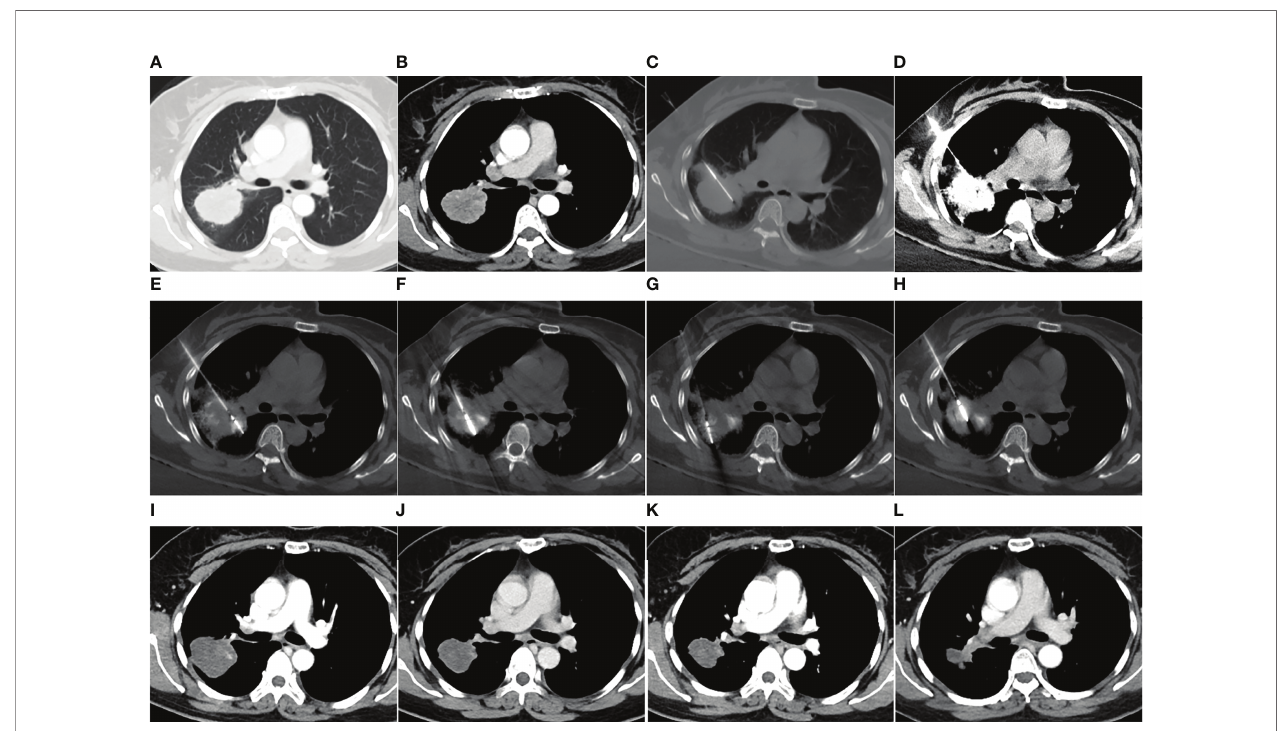
FIGURE 2 | MWA + ITC treatment of a large lung adenocarcinoma in the right upper lobe of a 48-year-old woman. Enhanced CT scan in the pulmonary (A) and mediastinal window (B) showing a nearly round mass with a diameter of 5.0 cm close to a large hilar vessel. (C) Insertion of a 21-gage Chiba needle into the side of the tumor near the hilar vessel. (D) Injection of 40 mg cisplatin aqueous solution containing 2 mL iodixanol into the mass, and diffusion of the agent over the entire tumor displayed by high-density iodixanol. (E – H) MWA using two antennae with multisite and multisession insertions. (I) Enhanced CT scan at 1-month follow-up showing complete necrosis. (J – L) Enhanced CT scan at 3-, 9-, and 18-month follow-up after MWA + ITC showing gradually involuting fi brosis of the necrotic zone and no local recurrence. MWA, microwave ablation; ITC, intratumoral chemotherapy; CT, computed